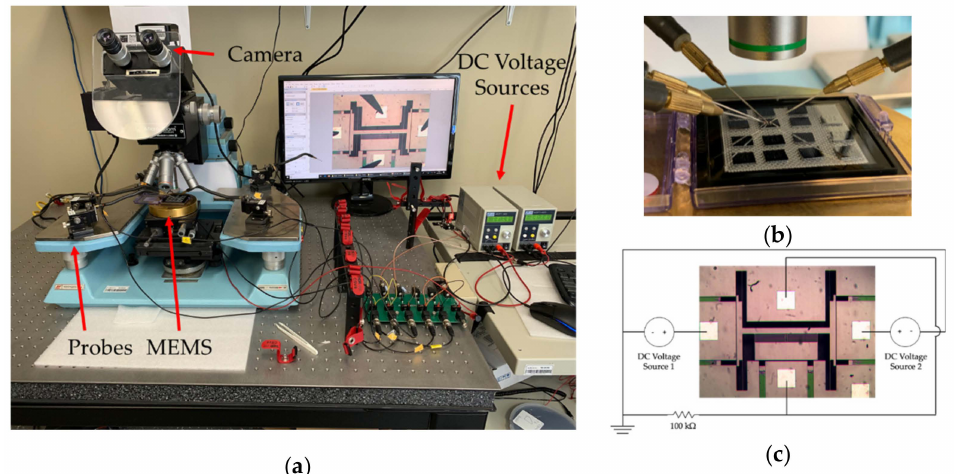
Figure 9. ( a ) Experimental actuation setup used; ( b ) zoomed in image of the probes on the MEMS device during tests; ( c ) schematic of the test circuit used for lateral actuation